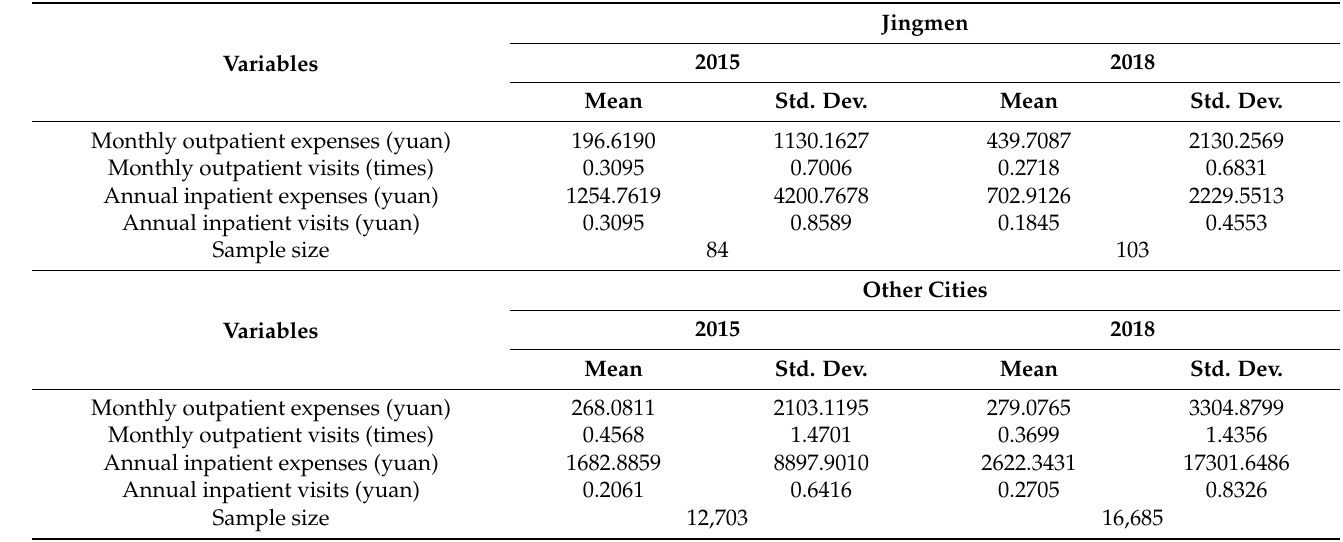
Table 1. Summary of the descriptive statistics.